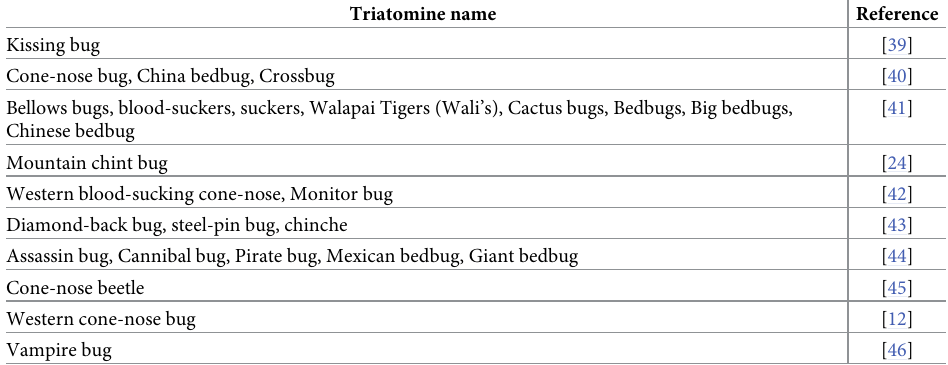
Table 4. Common names for triatomines in California reported in